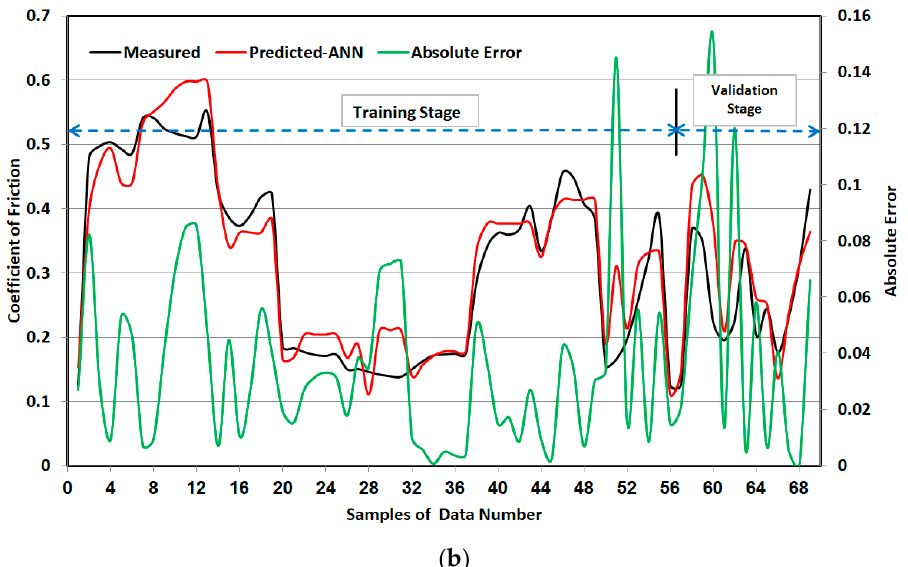
Figure 10. Comparisons between the predicted and actual friction coefficients for ( a ) single and ( b ) double hidden layers.